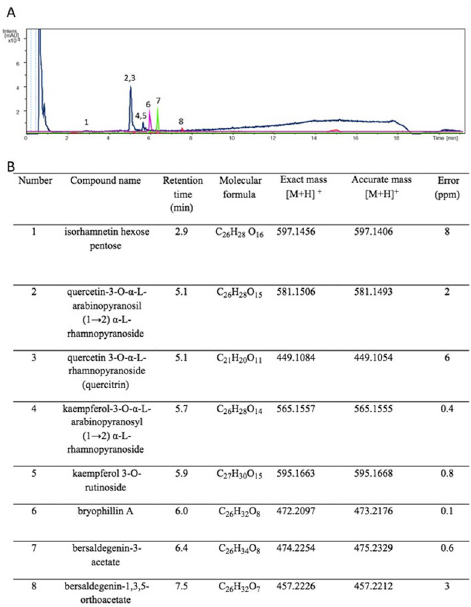
Fig 1. LABP chemical profile characterization. A. Overlapping of UV (ultraviolet) and EIC (extractedions) chromatograms obtained from analysis of LABP analyzed by UPLC/DAD-ESI/HRMS/MS (electrospray ionization— positive ion mode). The blue line corresponds to the UV chromatogram. The purple, green and red lines correspond to the EIC. B. The table shows the compounds annotated following the peaks, retention times, molecular formulas, and